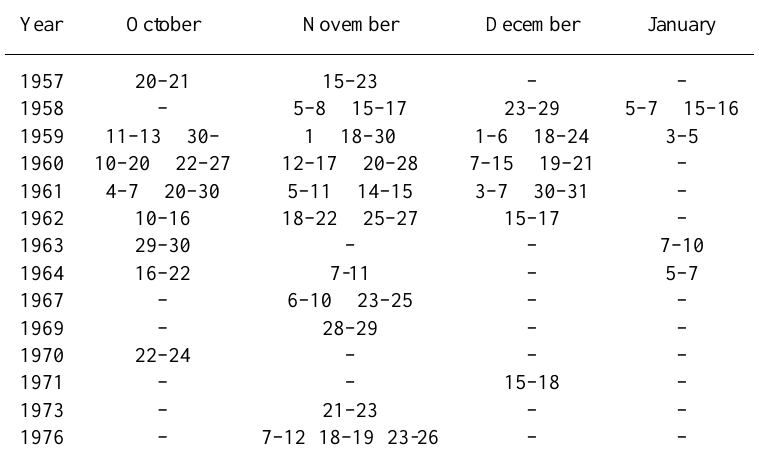
Table 1. Periods with total ozone < 220 matm-cm occurring at least over two North European stations during the 1957–1978 period.